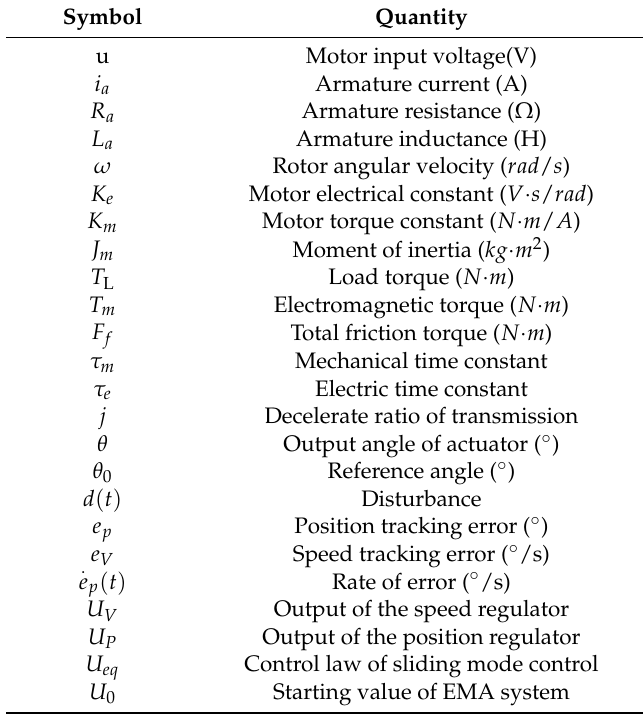
Table 1. Parameters value of EMA